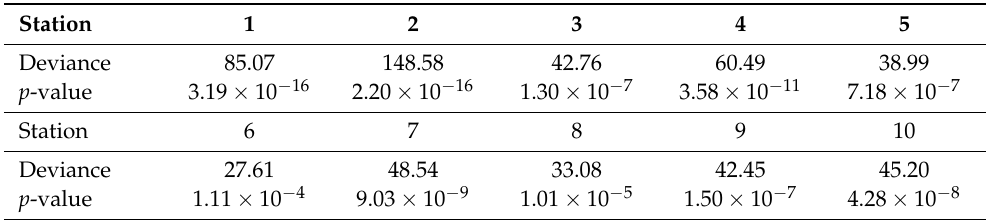
Figure 3. Trends in rainfall indices given as change per decade in % for R1day ( a ), PRCPTOT ( b ), R10 ( c ), R20 ( d ), R95p ( e ), SDII ( f ), RX1day ( g ), and RX5days ( h ). Upward/downward triangles denote stations with statistically significant upward/downward trends at the 5% significance level. Circles show stations with non-significant changes. Maps are obtained by interpolating station values using the IDW method. Table 4. Performance of the deviance test at a 5% significance level for all the climate stations using the p -values associated with deviance value (see Figure 1 for station